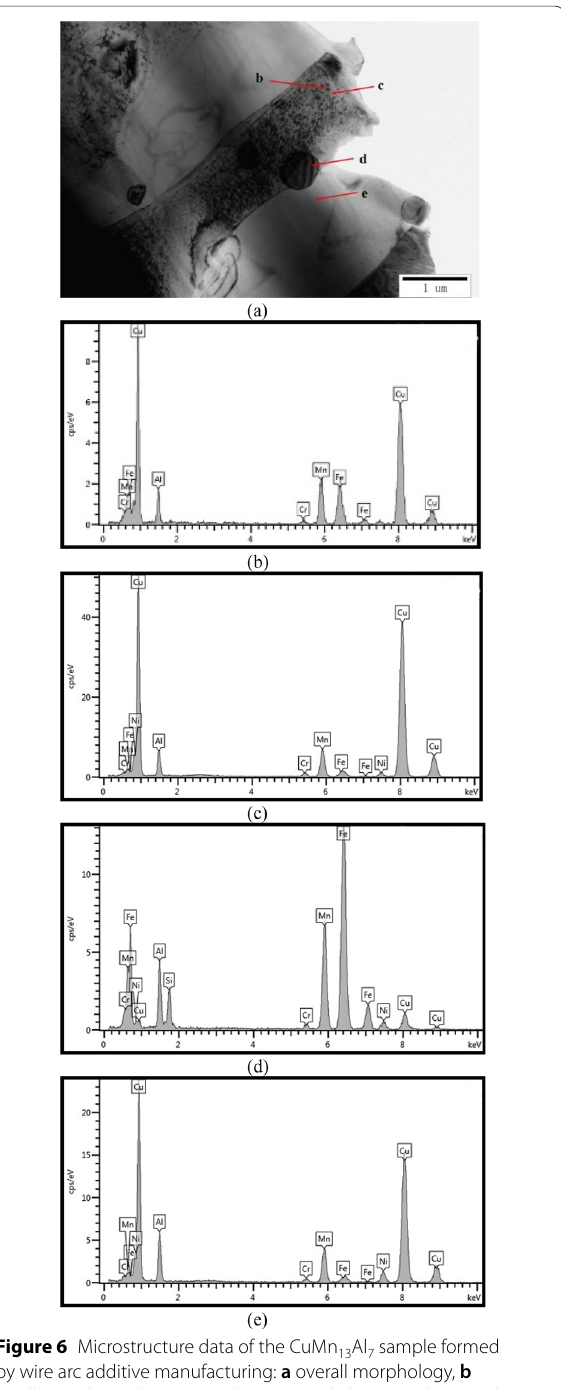
Figure 6 Microstructure data of the CuMn 13 Al 7 sample formed by wire arc additive manufacturing: a overall morphology, b small particles and corresponding EDS, c dark matrix phase and corresponding EDS, d large particles and corresponding EDS, and e light matrix phase and corresponding